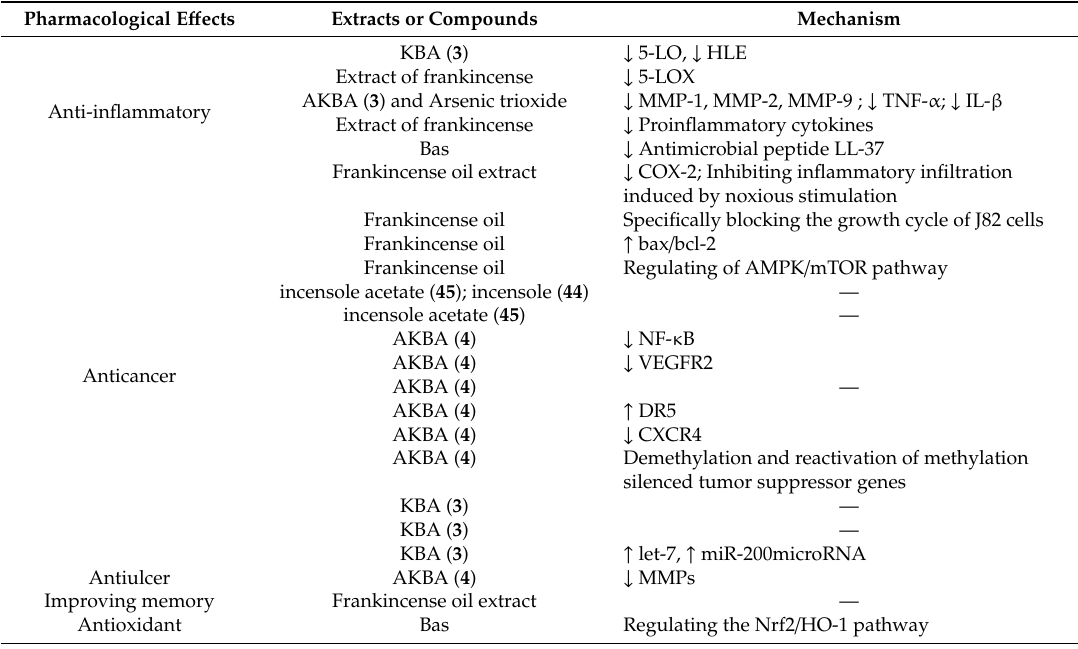
Table 2. The pharmacological e ff ects and mechanisms of